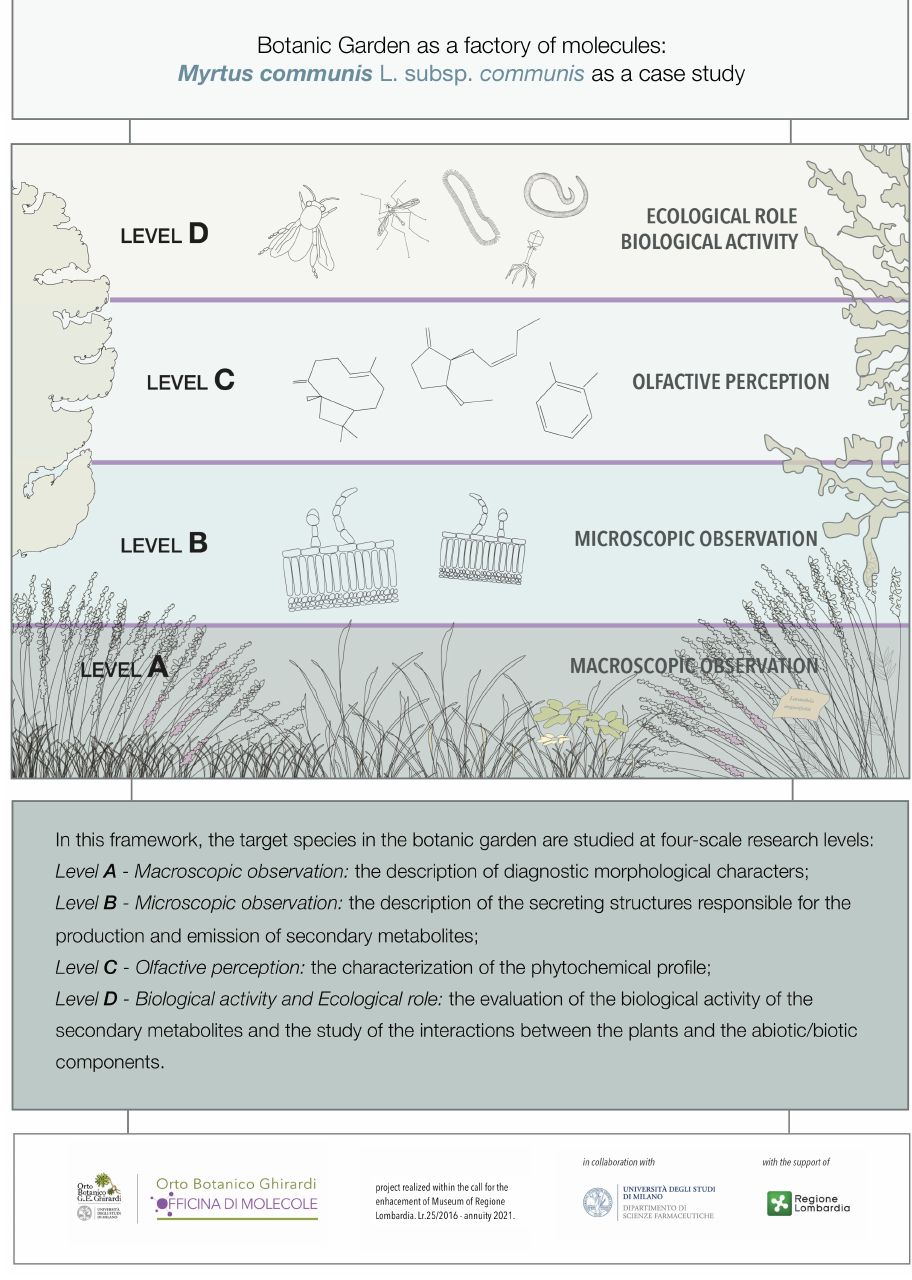
Figure 1. Main iconography of the project “Ghirardi Botanic Garden, factory of